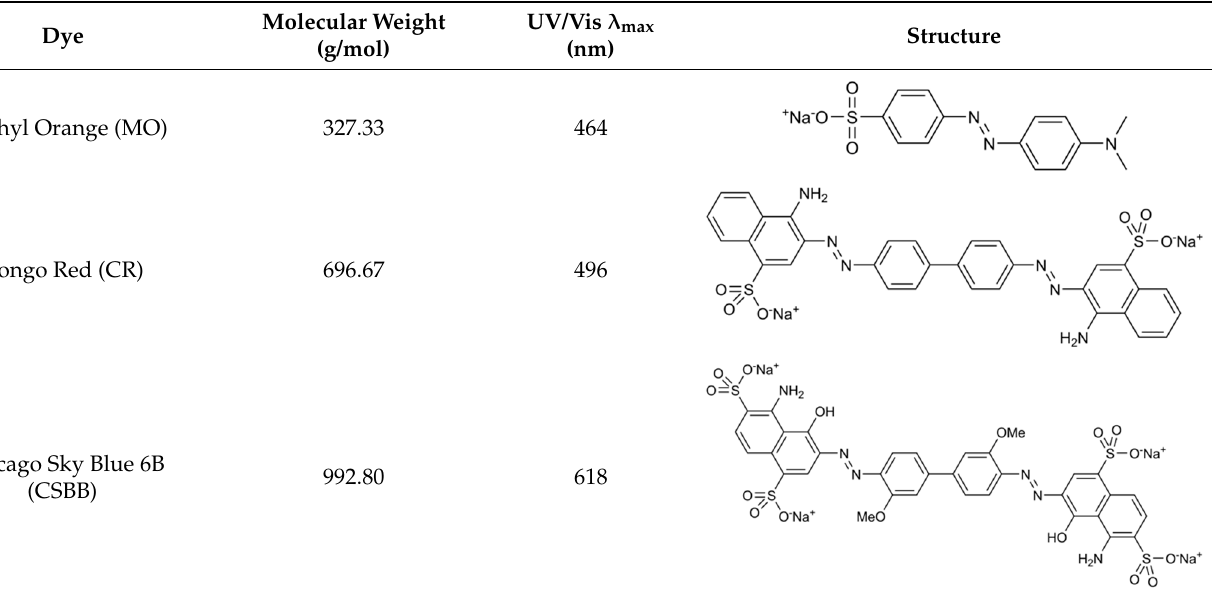
Table 1. Chemical and structural properties of azo dyes.